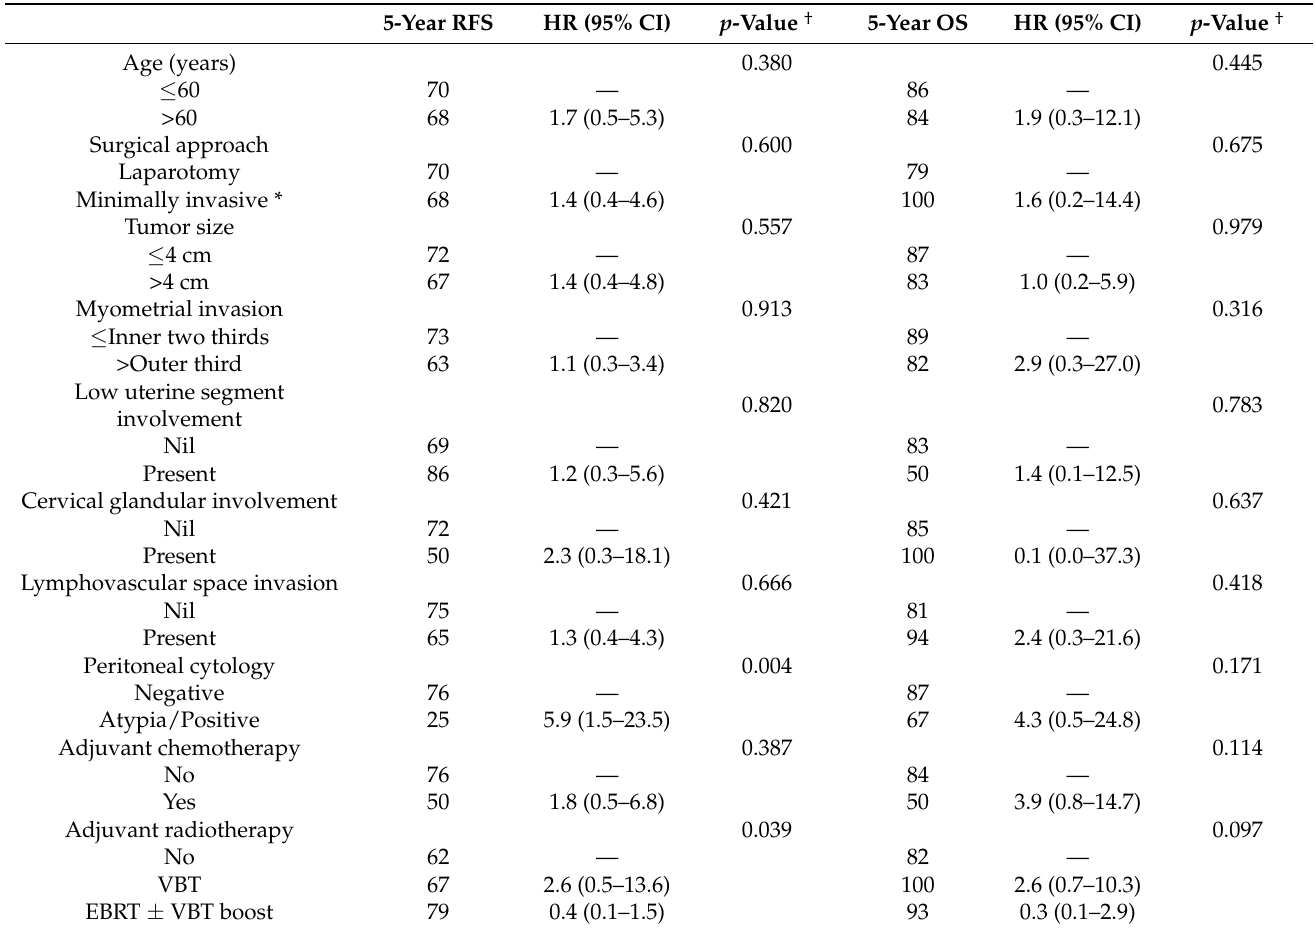
Table 3. Parameter analysis of potential prognostic factors in IB grade 3